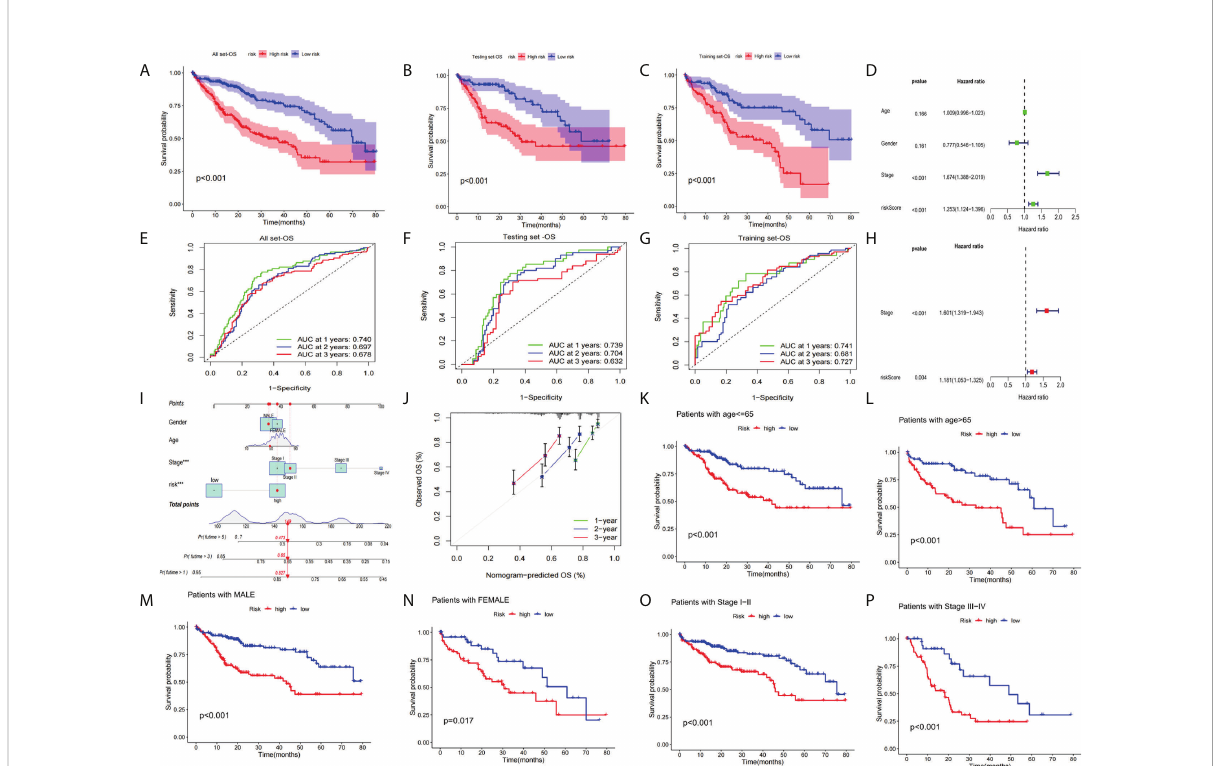
FIGURE 7 Validation of the prognostic value of the signatures. (A – C) The KM curve of all sets, testing set, and training set. (D) Univariate Cox regression analysis and multivariate Cox regression (H) analysis risk score and clinical stage as independent predictors of OS. (E – G) ROCs for 1-year, 2- year, and 3-year OS prediction. (I) The nomogram of the risk score and clinical parameters (age, gender, and stage) of all sets. (J) The calibration curves displayed the accuracy of the nomogram in the 1st, 2nd, and 3rd years. (K, L) Comparison of the OS between the high-risk and low-risk groups of patients who are<= 65 or > 65 years, male (M) or female (N) with a stage of stage I-II (O) or stage III-IV (P)